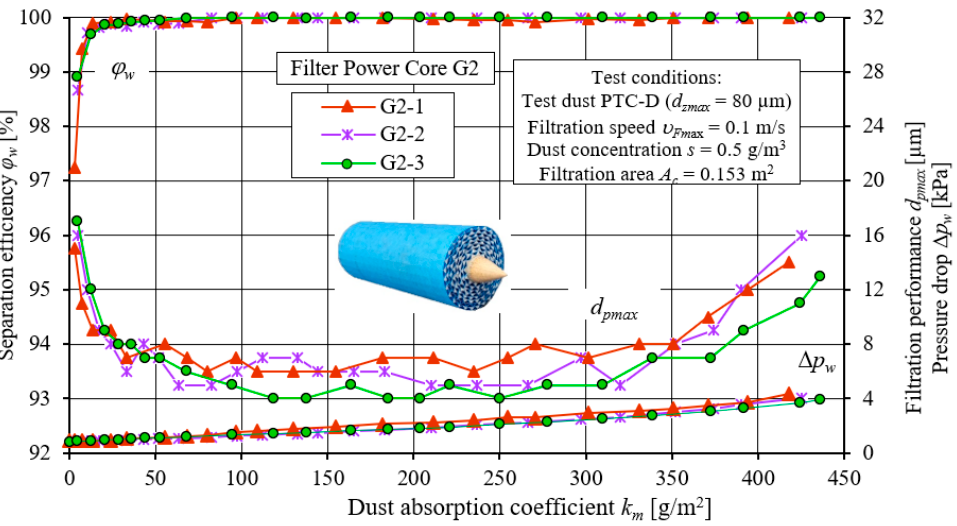
Figure 18. Characteristics of separation efficiency ( φ w ) and filtration performance ( d pmax ) and